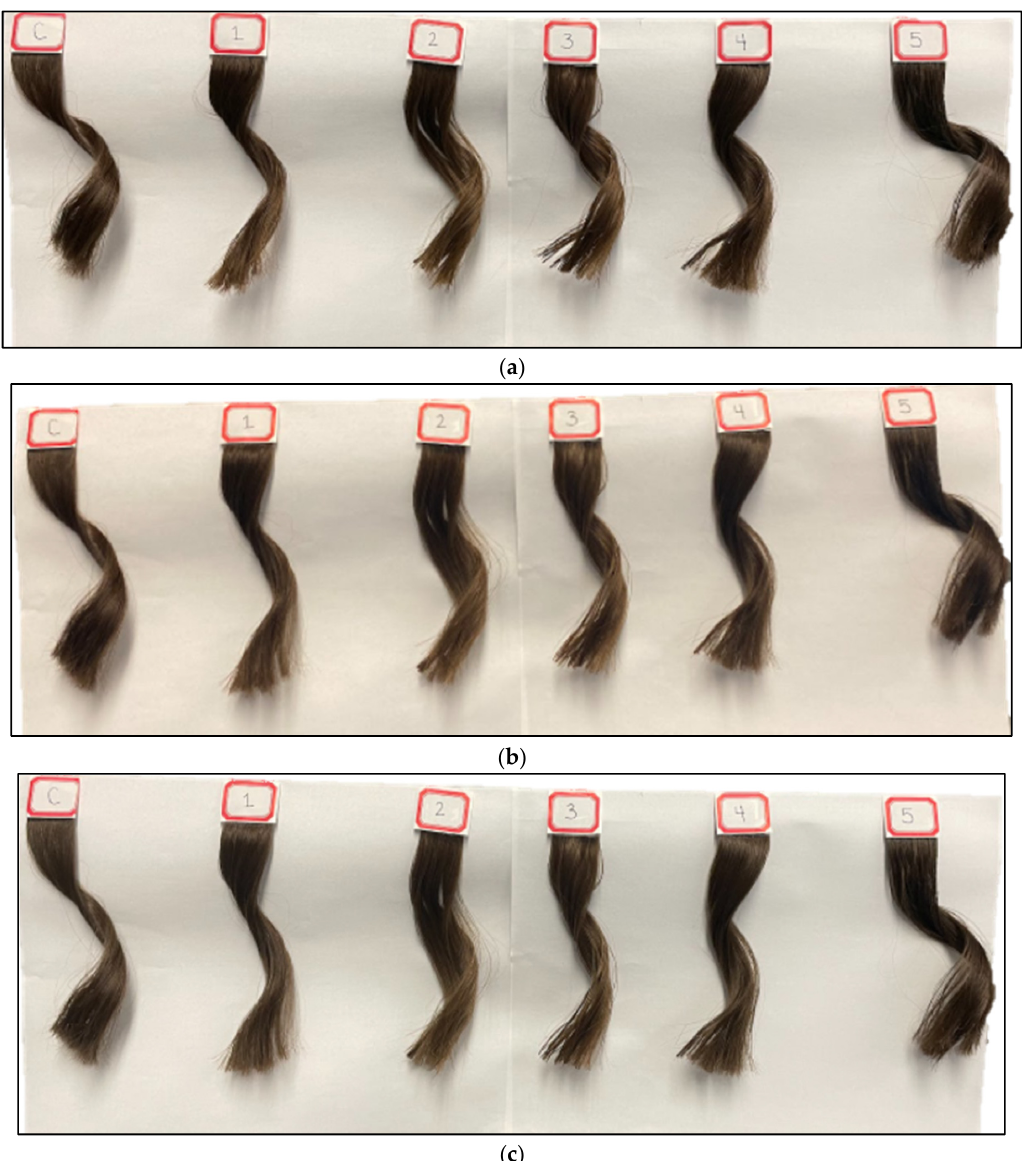
Figure 6. ( a ): Control piece of hair (far left) next to Samples 1 (next to control) through 5 (far right) curl drop test. Photo was taken at 0 h right after gel application. ( b ): Control piece of hair (far left) next to Samples 1 (next to control) through 5 (far right) curl drop test. Photo was taken at 24 h right after gel application. ( c ): Control piece of hair (far left) next to Samples 1 (next to control) through 5 (far right) curl drop test. Photo was taken 48 h after gel